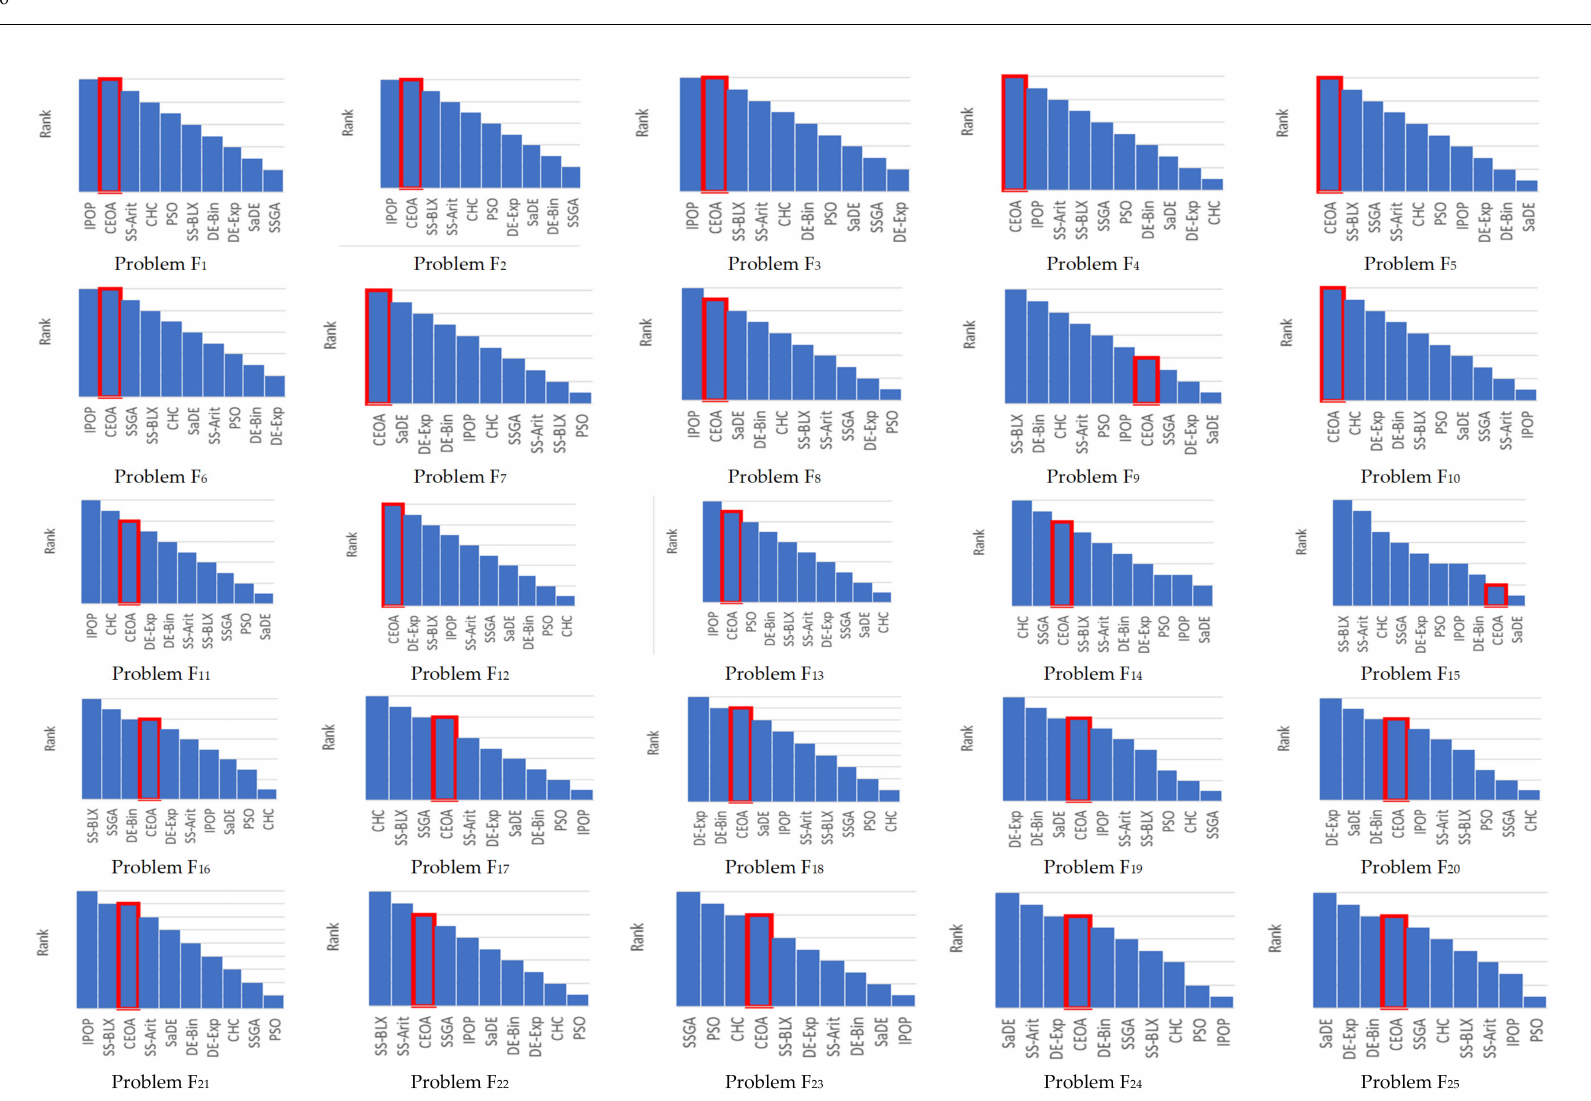
Figure 4. Comparison between the different algorithms according to its ranks with different